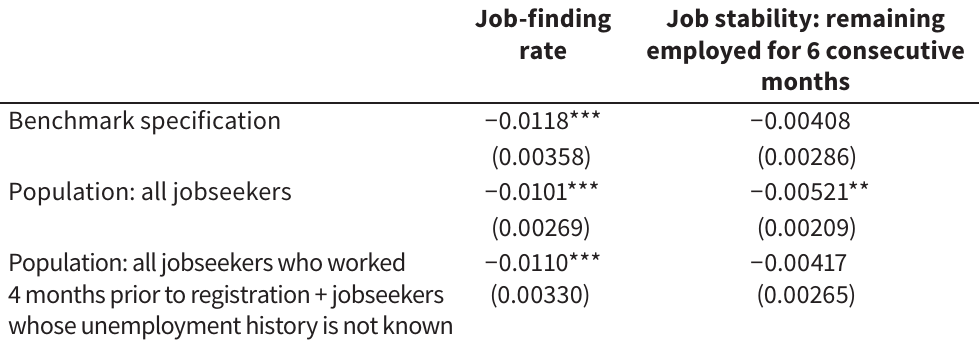
The effect of the subsidy for different populations